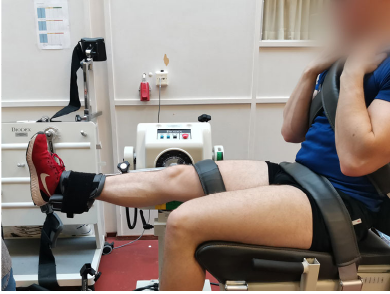
Methods Protoc. 2023 , 6 , x FOR PEER REVIEW Figure 3. Testing position of knee extension and flexion. Figure 3. Testing position of knee extension and flexion. Figure 3. Testing position of knee extension and flexion. Figure 3. Testing position of knee extension and flexion.